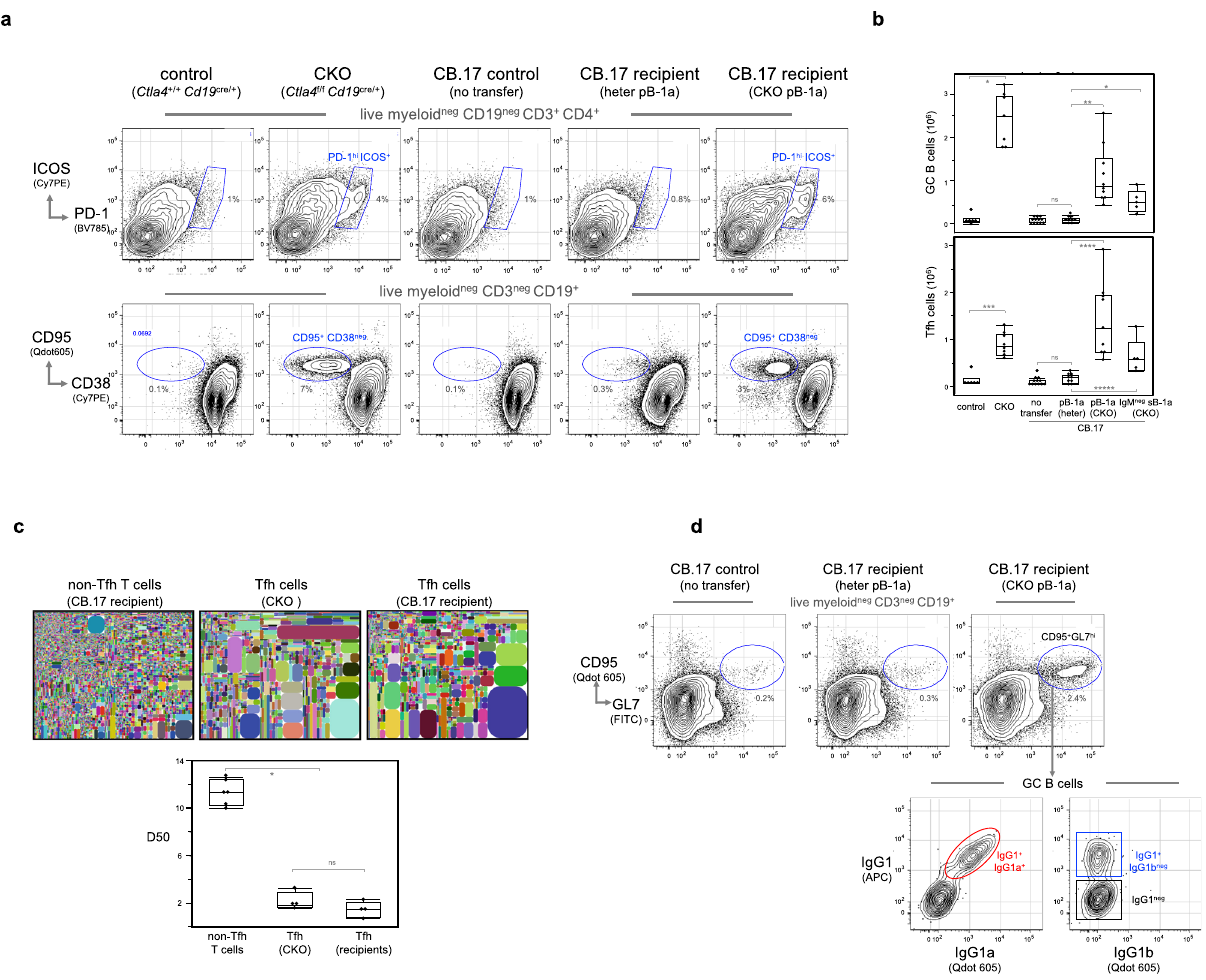
Fig. 7 CTLA-4-de fi cient B-1a cells and their IgM neg decedents induce Tfh cells and GCs in congenic recipients. a Live CD4 + T cells and CD19 + B cells from spleens of indicated mice were gated to reveal Tfh (PD-1 hi ICOS + ) and GC B (CD95 hi CD38 neg ) cells, respectively. b Data summarizing the numbers of Tfh and GC B cells in spleens of indicated mouse groups is shown, n = 7 – 10 mice per group. Each dot represents data for an individual mouse, * p < 0.003, ** p < 0.0002, *** p < 0.002, **** p < 0.0003, ***** p < 0.004, ns, not signi fi cant ( p < 0.2), nonparametric Wilcoxon one-way test. About 5 × 10 6 of nucleotide sequences expressed by non-Tfh T and Tfh cells from indicated mice. One representative plot from four or six independent T-cell samples is shown. Each rectangle in a given tree-map represents a unique CDR3 nucleotide sequence and the size of each rectangle denotes the relative frequency of an individual CDR3 sequence. The box plot summarizes the D50 metric analysis that quanti fi es TCR β CDR3 nucleotide sequence diversity for each T-cell sample from indicated mouse group. Each dot represents data for a T-cell sample from an individual mouse, n = 4 – 6 T-cell samples per group, * p < 0.006, ns, not signi fi cant ( p < 0.2), nonparametric Wilcoxon one-way test. Low D50 values are associated with less TCR β CDR3 diversity. Sequence information for each T-cell sample is summarized in supplementary Table 3. d Live myeloid neg CD3 neg CD19 + splenic B cells from indicated CB.17 mice were gated to reveal GC B cells (CD19 + CD95 + GL7 + ), which were further gated to show IgG1, IgG1b and IgG1a surface expression. Statistical summary for fi ve independent experiments is shown in Supplementary Table 5. Box plots in b , c : box draws 75% (upper), 50% (center line) and 25% (down) quartile, the maxima and minima outliers are shown as top and bottom line,